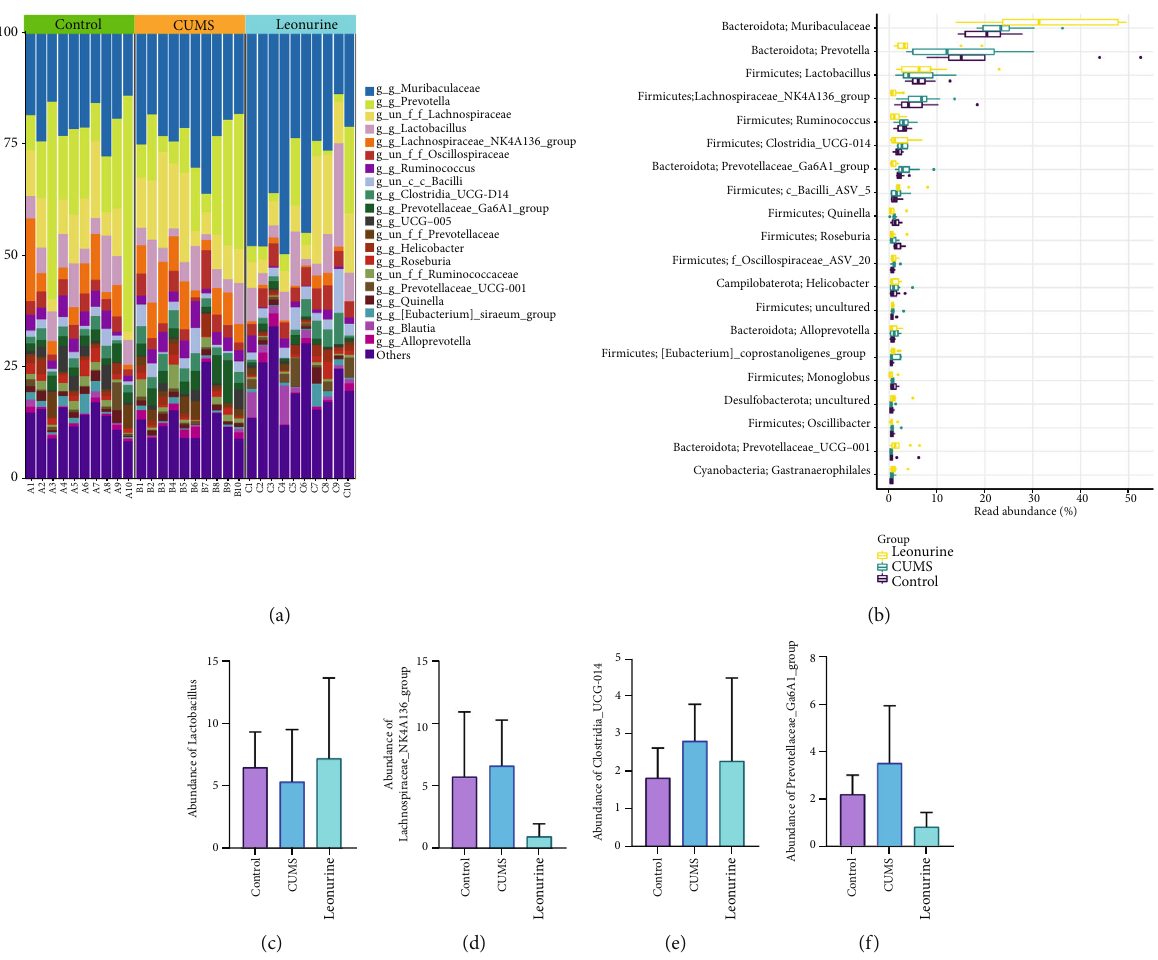
Figure 4: The e ff ects of leonurine on gut microbiota in CUMS rats. (a) Top 20 dominant gut microbiota with relative abundance at the genus level. (b) Relative abundance of microbiota at the genus level. (c – f) Relative abundance comparison of Lactobacillus , Lachnospiraceae_NK4A136_group , Clostridia_UCG-014 , and Prevotellaceae_Ga6A1_group in the Control, CUMS, and Leonurine